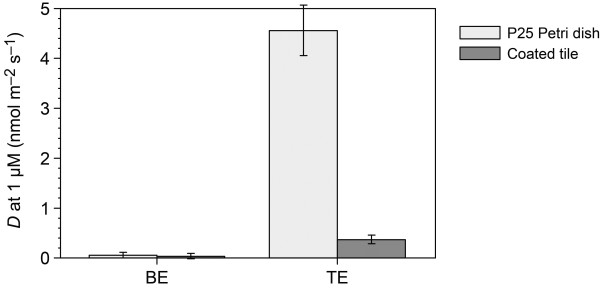
MB degradation rate at 1 mmol m-3 (1 μM) MB for P25 Petri and tile samples. The BN and TN samples are not shown because the MB degradation without irradiation is negligible. Estimated errors ± 10 % + 0.05 nmol m-2 s-1.